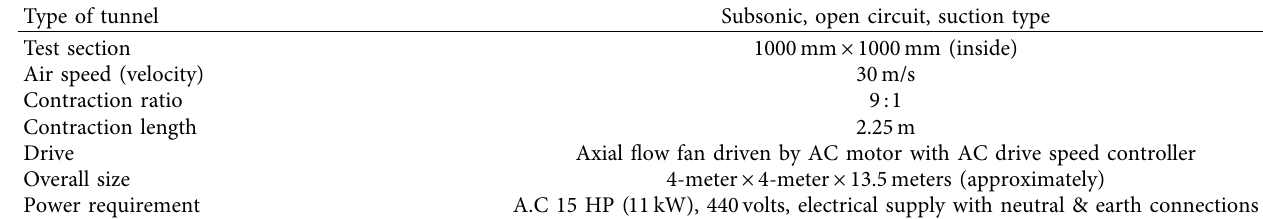
Table 3: Specifications of wind tunnel.